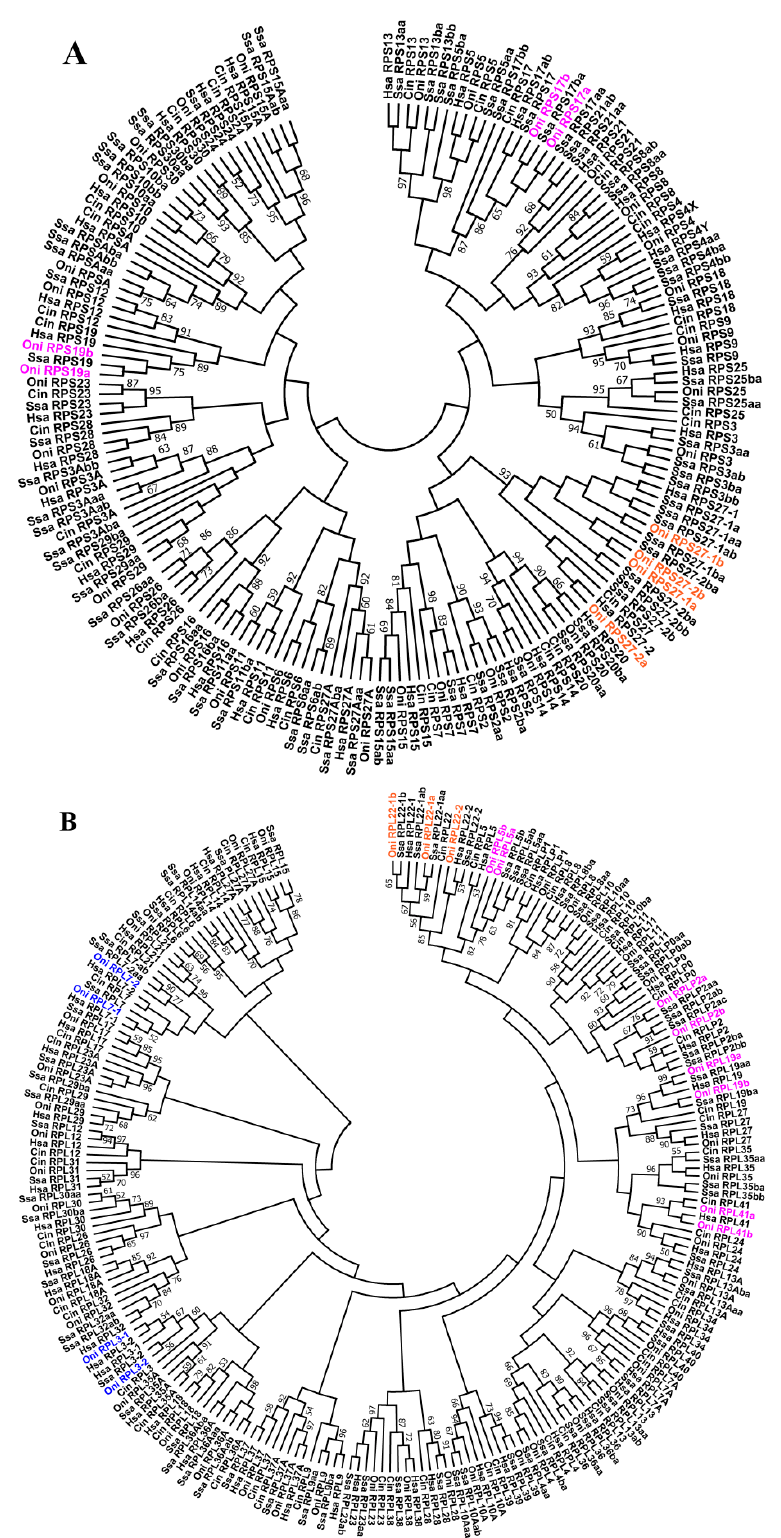
Figure 3. Phylogenetic tree of the small subunit ( A ) and large subunit ( B ) RP genes from sea squirt (1R), human (2R), tilapia (3R) and Atlantic salmon (4R). Gene name in blue indicates genes derived from 2R event in vertebrates. Gene name in magenta indicates genes derived from3R event in teleosts. Gene name in orange indicates genes derived from both 2R and 3R events. Cin , Cionaintestinalis ; Hsa , Homo sapiens ; Oni , Oreochromis niloticus ; Ssa , Salmo salar .